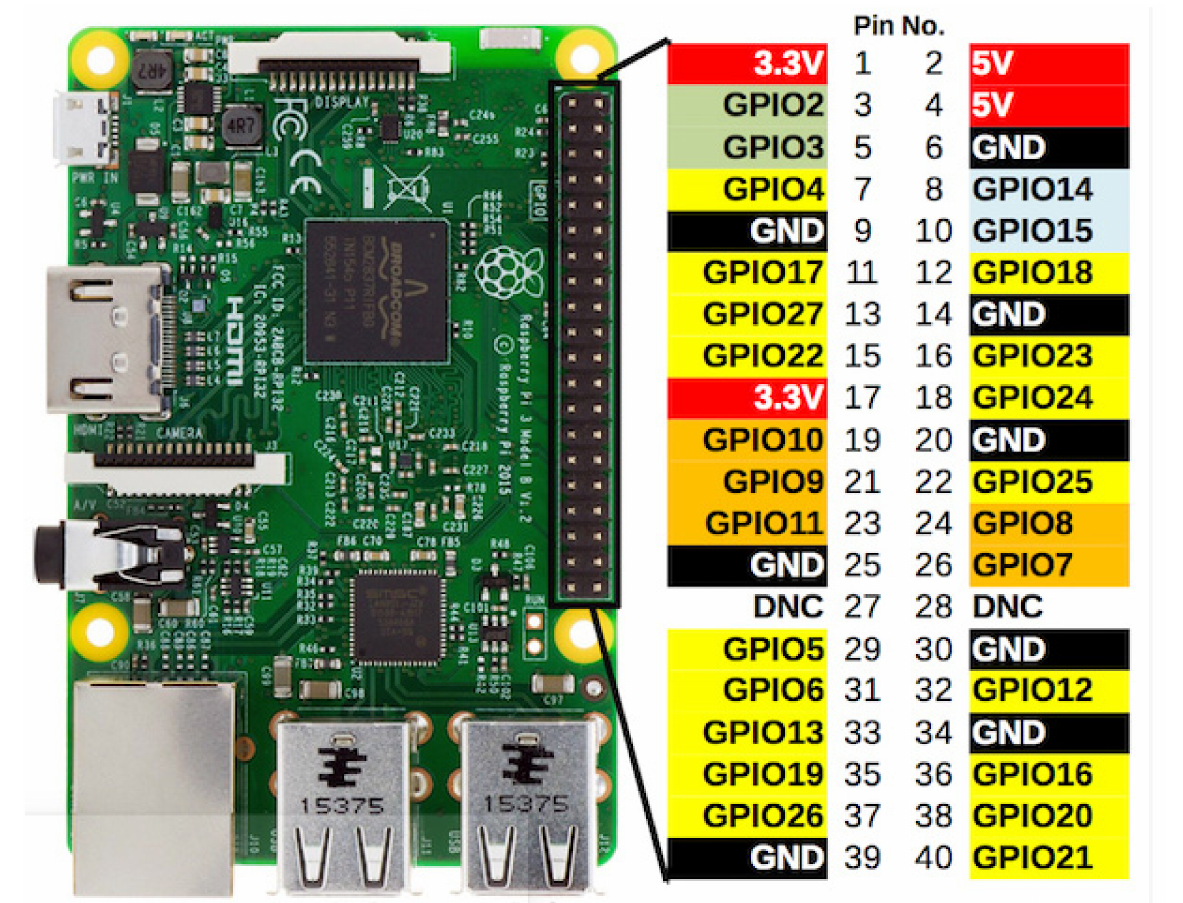
Figure 20. Raspberry Pi board presentation.